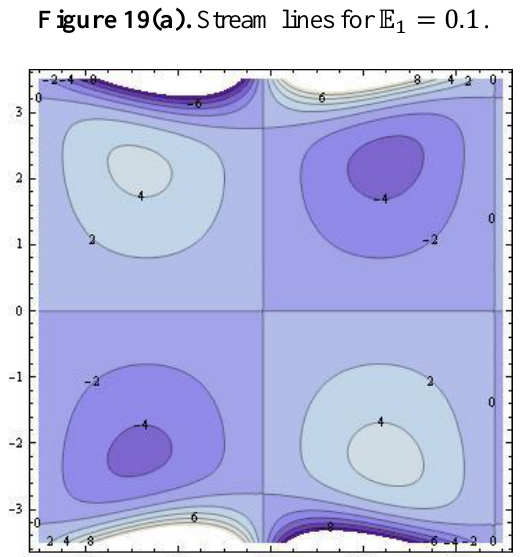
Figure 19(a). Stream lines for 𝔼